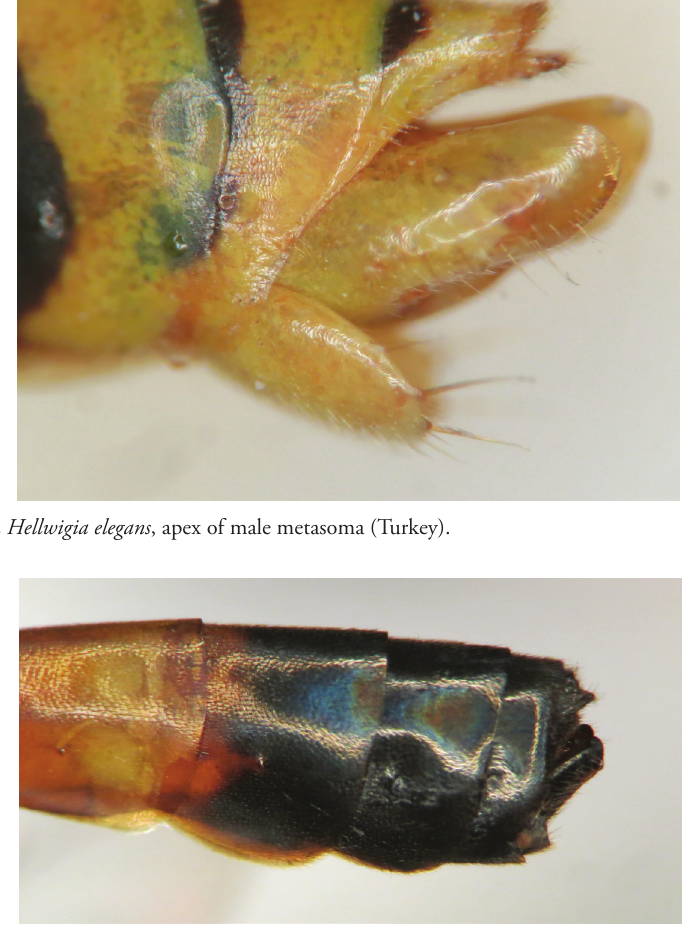
Figure 12. Heinrichiella obscura comb. n., apex of male metasoma